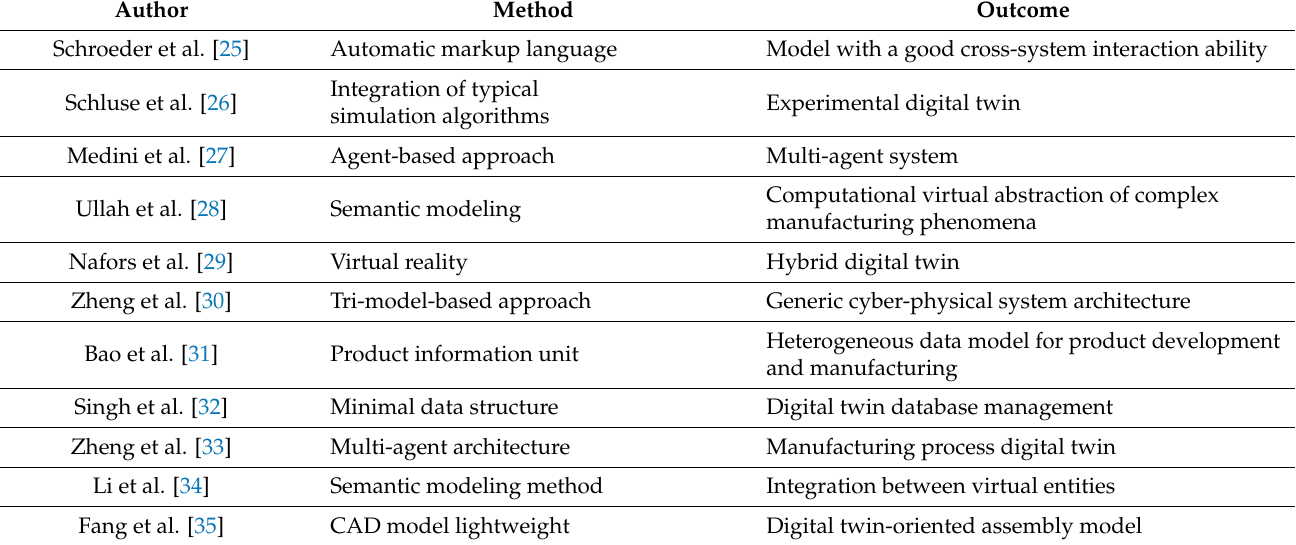
Table 2. Typical product digital twin modeling work